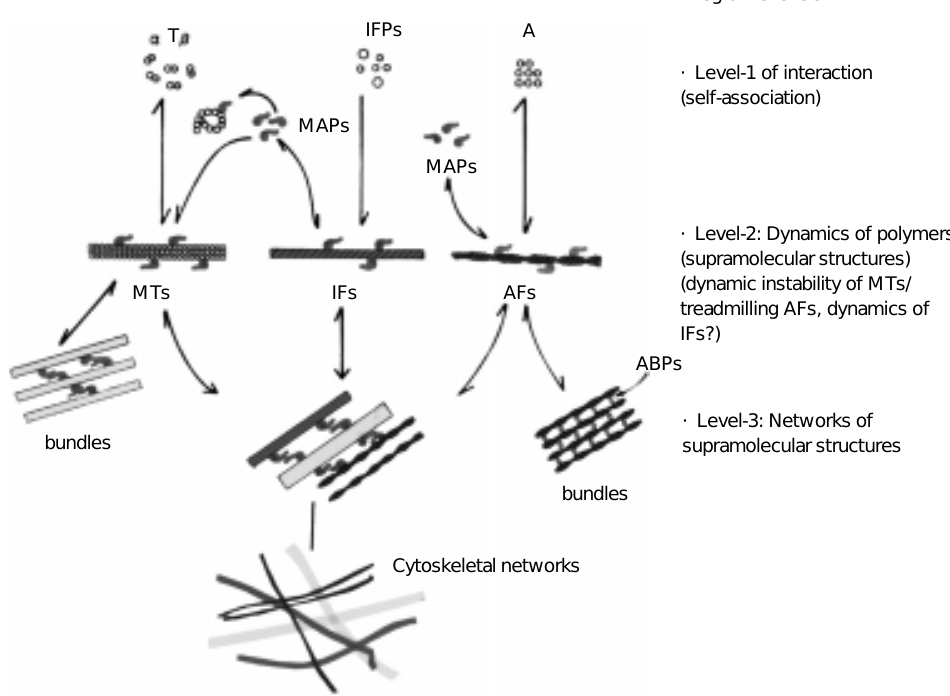
Figure 1 - Simplified scheme showing the three integrative levels in the process by which macromolecular units assemble into cytoskeletal polymers, and their association to form su- pramolecular structures, mainly bundles of these polymers, and networks involving microtubules (MT), intermediate filaments (IF) (neurofilaments) and actin fila- ments (AF). Microtubule-associ- ated proteins (MAPs) appear to play a major modulatory role at the level of microtubule assem- bly and in regulating the linkages between the different filaments of the cytoskeleton. T, Tubulin; A, actin; ABPs, actin binding pro- teins; IFPs, intermediate-fila- ments